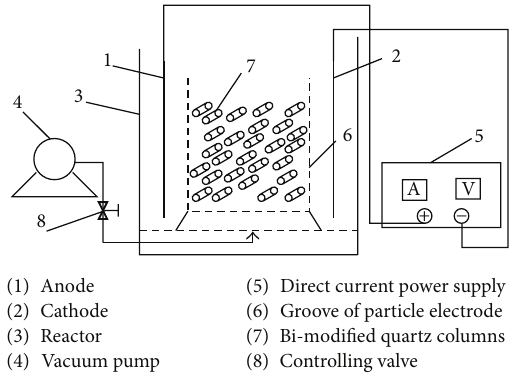
Figure 1: Schematic diagram of the experimental